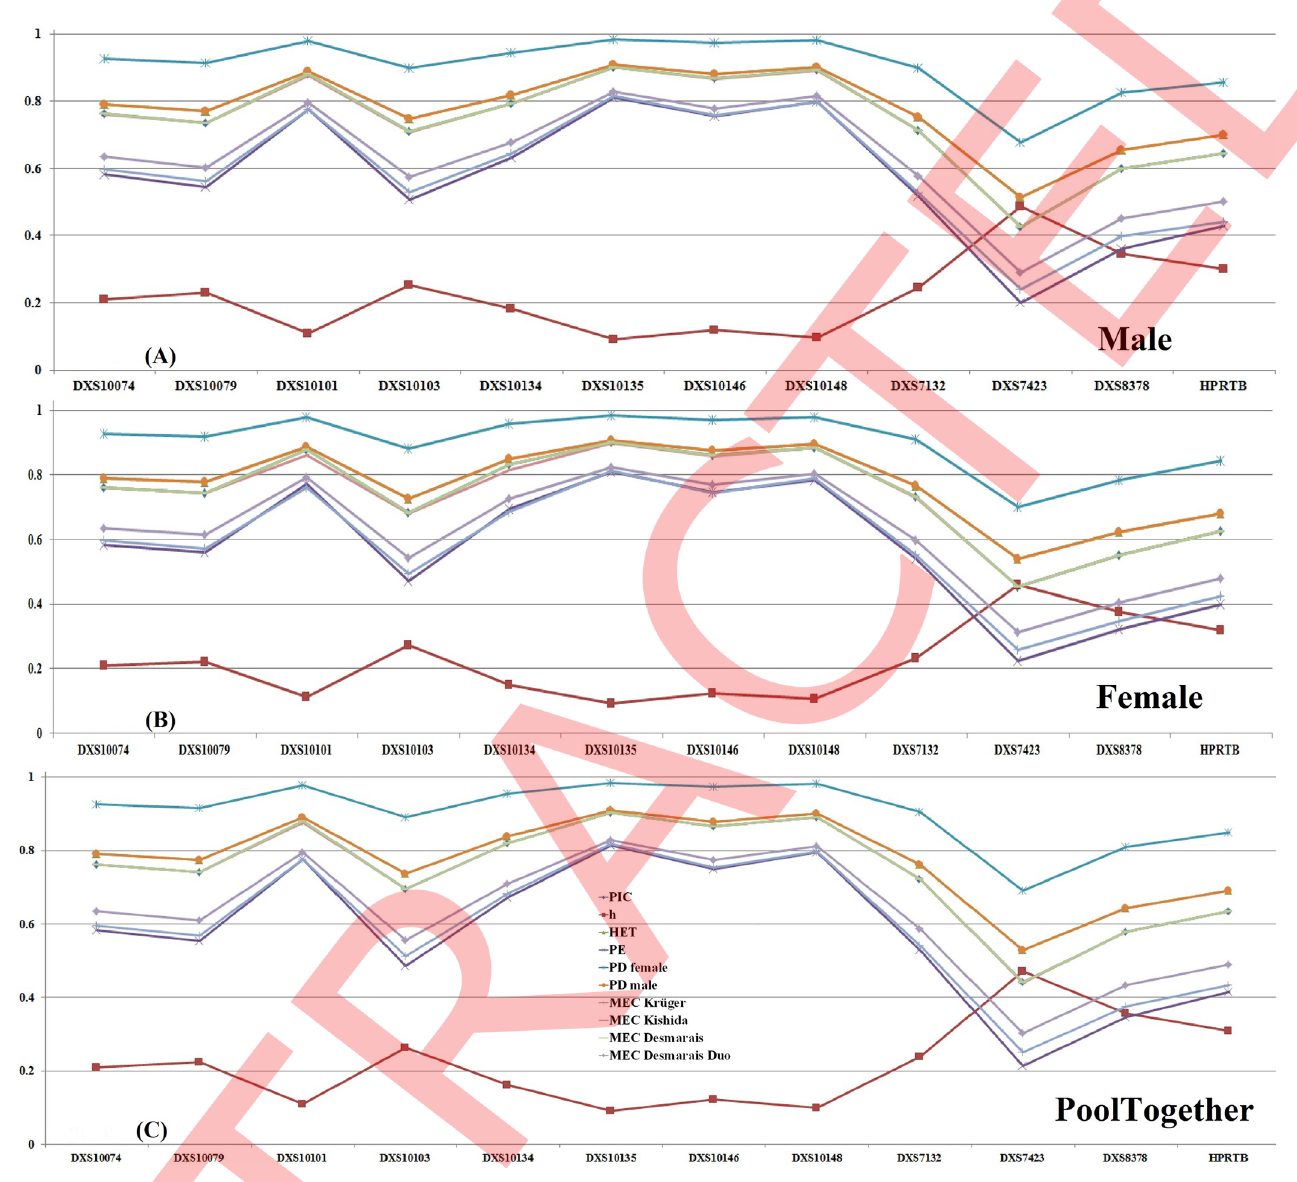
Fig 1. Forensic parameters of the 12 X-STR loci in Highlander Tibetan population Parameters were calculated on the basis of allele frequencies in males (A), females (B) and both pooled together (C). for the genotyping of males. These four haplotype groups (LG1, LG2, LG3, and LG4) showed a higher number of haplotypes in Highlander Tibetans males were 161,112, 96 and 108, respec- tively, whereas haplotype diversities (HD) were 0.9959, 0.9880, 0.9809 and 0.9873, respectively ( S4 Table ). In LG1, LG2, LG3, and LG4, the unique haplotypes were 101, 64, 55 and 56, respectively, while accepted heterozygosity was 0.8247, 0.7742, 0.7819 and 0.7400, respectively. Linkage disequilibrium refers to the non-random association of alleles at two or more loci in a population. When alleles are in linkage disequilibrium, haplotypes do not occur at the expected frequencies. We accepted to observe tight linkage between the STR trios in the four linkage groups and we would not assume any linkage among the STRs in different linkage